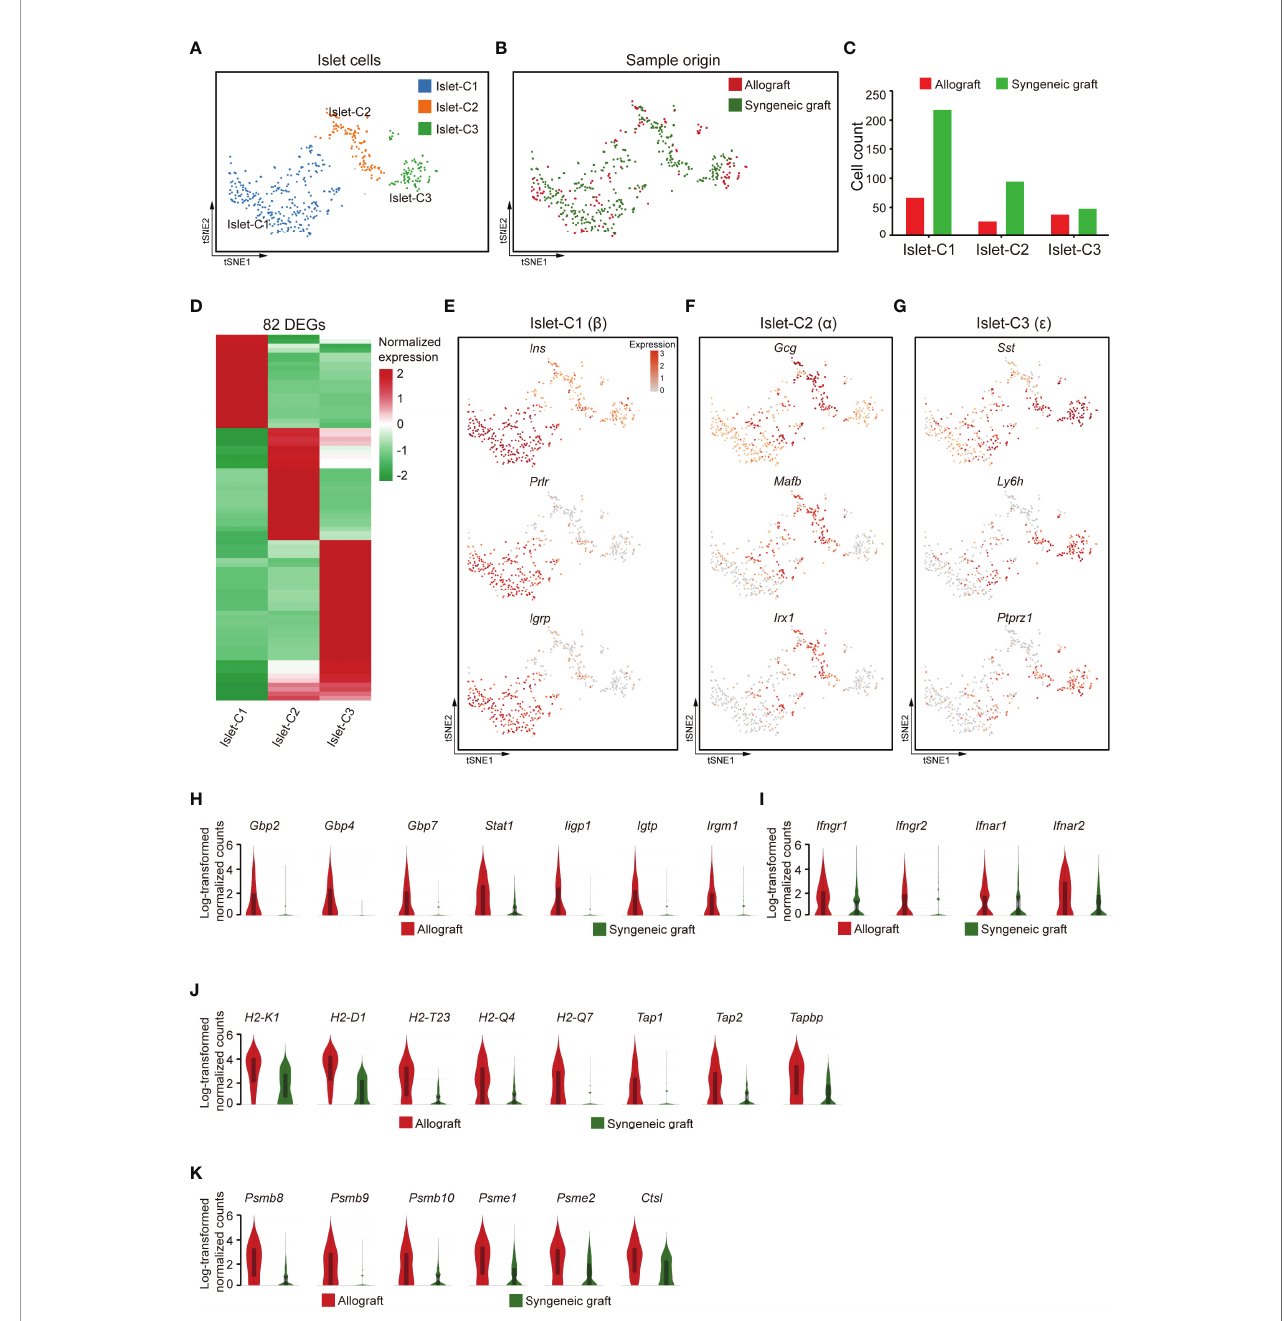
FIGURE 6 | Islet cells exhibited an activated gene expression signature 7 days post-allogeneic transplantation. (A, B) UMAP visualization of islet cells, with each cell colorcoded for the associated cell subtype (A) and sample origin (B) . (C) The number of islet cells in the indicated clusters. (D) Heatmap showing DEG expression within 3 subclusters of islet cells. (E – G) t-SNE visualization of the signature genes for 3 subclusters of islet cells: islet -C1 (E) , islet -C2 (F) , islet -C3 (G) . (H – K) Violin plots showing the smoothened expression distribution of IFN-inducible genes (H) , receptors for interferon ligands (I) , MHC class I molecules (J) , and proteasome subunit genes (K) in islet cells from allografts and syngeneic